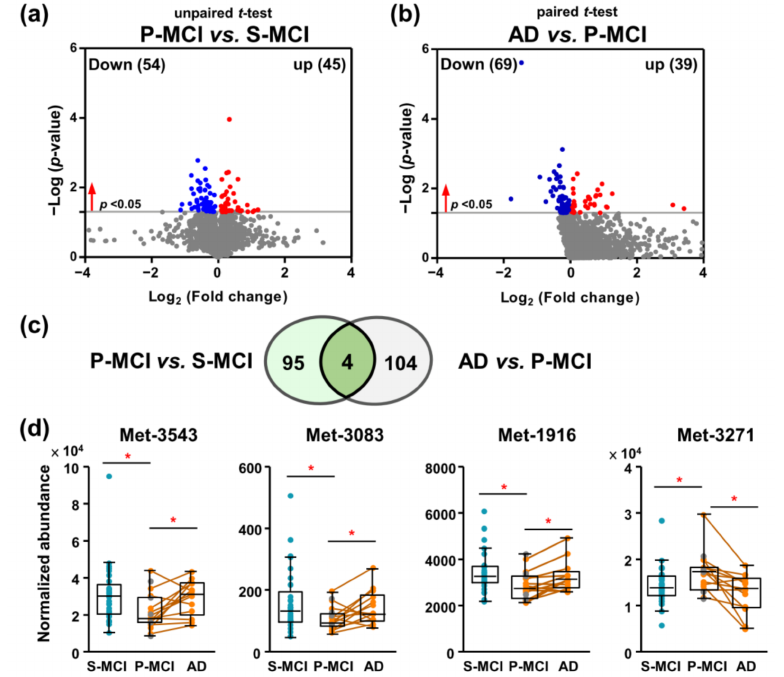
Figure 1. Longitudinal and cross-sectional analysis comparing the plasma metabolomic data of MCI patients. ( a ) Comparison of the metabolic profiles between 19 P-MCI and 29 S-MCI patients based on independent t -tests. A total of 99 metabolic features were statistically significant ( p < 0.05). ( b ) Com- parison between 13 paired P-MCI and AD groups to identify differential metabolites associated with AD development based on paired t-tests. A total of 108 metabolic features were statistically significant ( p < 0.05). ( c ) A Venn diagram of the comparison between the P-MCI vs. S-MCI and P-MCI vs. AD metabolic features. ( d ) Box and whisker plots of four common metabolic for differentiating the S-MCI, P-MCI, and AD patients based on paired and independent t -tests. Paired samples are connected by lines. Grey dots represent six P-MCI subjects without AD metabolomics data. * p < 0.05. S-MCI, stable MCI; P-MCI, MCI proceeding to